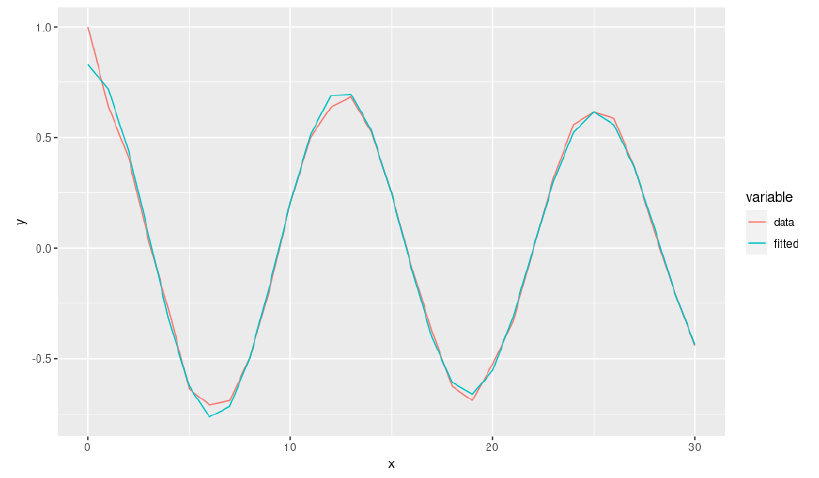
Figure 6. Autocorrelation of the artificial time series